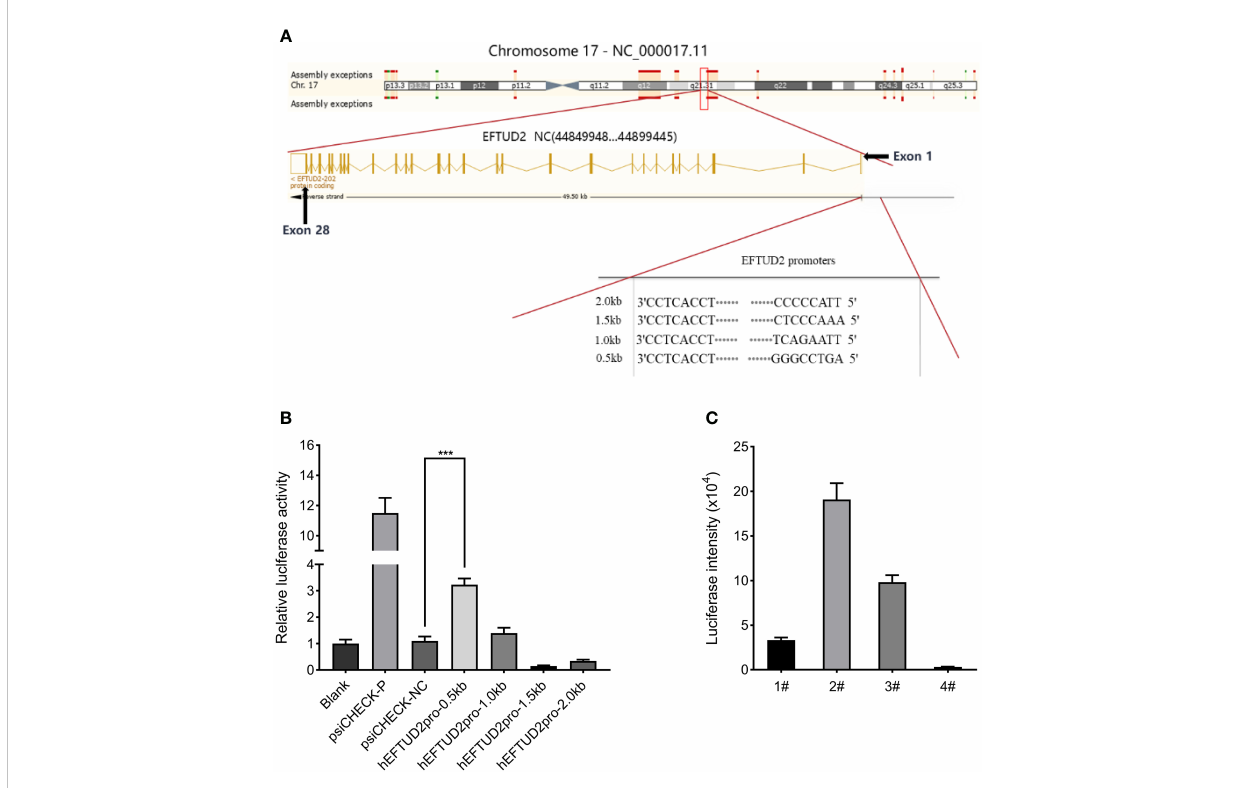
FIGURE 2 Construction of the Epro-LUC-HepG2 cell line. (A) Prediction of the EFTUD2 promoter sequences was performed according to the ENCODE data. (B) The luciferase analysis showed that the hEFTUD2pro-0.5 kb promoter had the strongest activity. (C) Stable transgenic Epro-LUC-HepG2 cell line (2#) was selected and the luciferase intensity was displayed. ***, P <